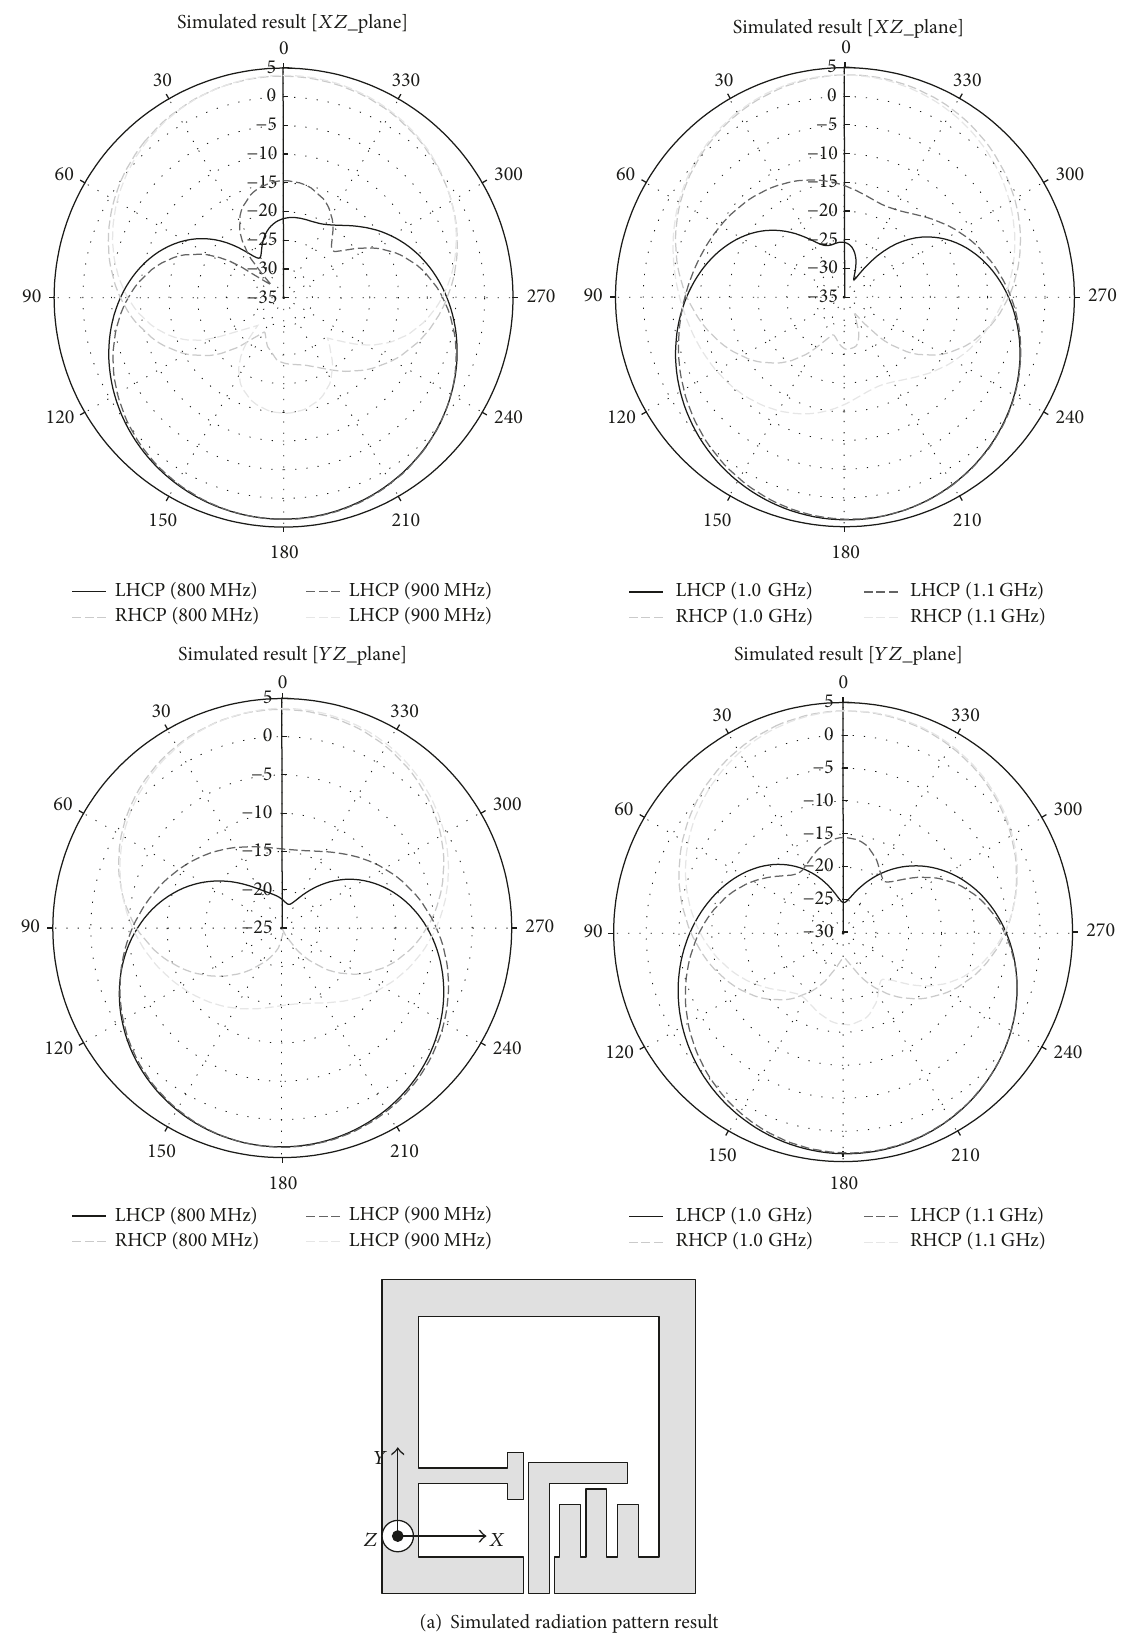
(a) Simulated radiation pattern result Figure 8: